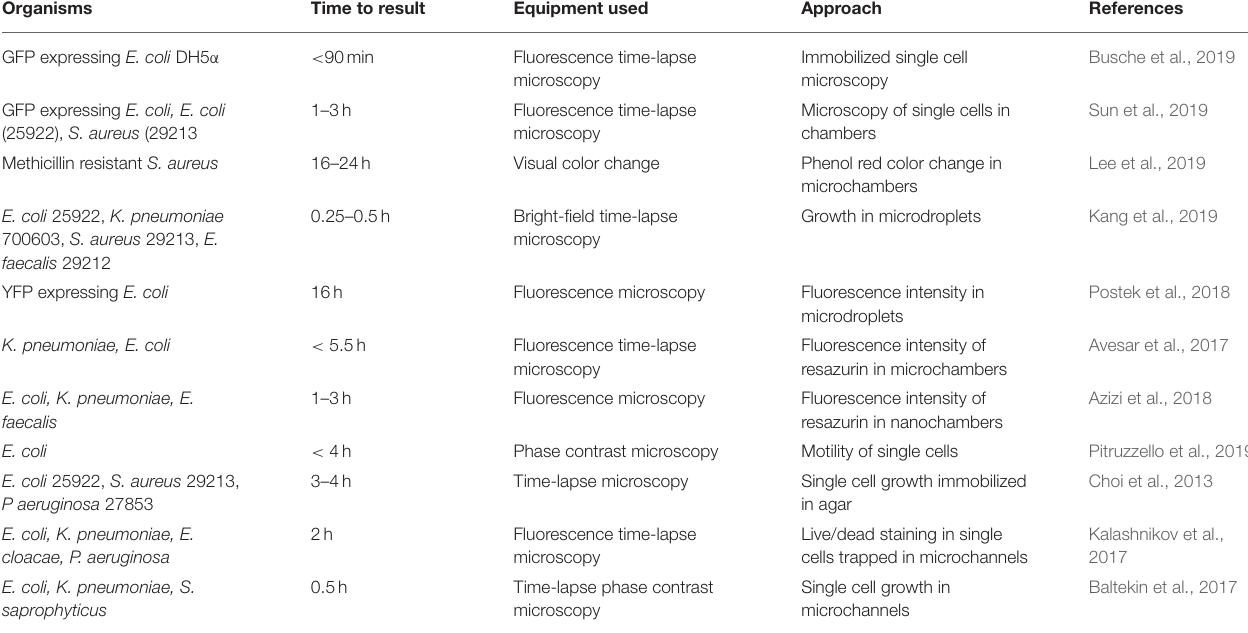
TABLE 1 | Summary of phenotypic antimicrobial susceptibility